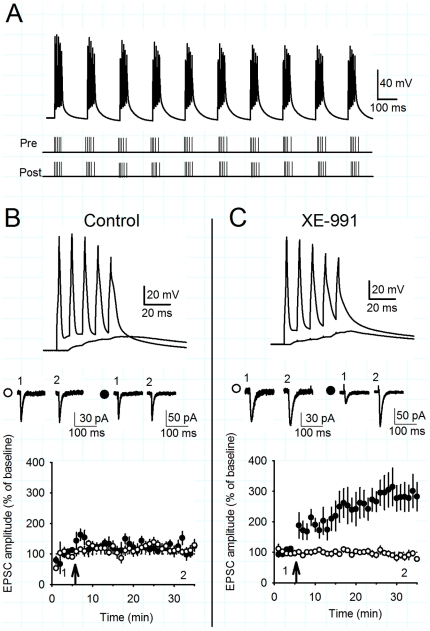
XE-991 facilitates the induction of LTP by theta burst pairing.A) Diagram of theta burst pairing (TBP) protocol. Top, voltage trace of TBP protocol recorded at the soma of a CA1 pyramidal cell. Middle and bottom traces illustrate the timing of inputs to the stimulating and recording electrodes evoking EPSPs and somatic action potentials respectively. B) TBP does not induce LTP under control conditions. Coincident TBP of subthreshold EPSPs and somatic action potentials induced no change in EPSC amplitude in the test (black circles) or control (white circles) pathways. The arrow indicates the timing of the TBP protocol. Example voltage traces show the initial burst of 5 coincident EPSPs and action potentials and a single test burst of 5 subthreshold EPSPs. Example current traces from a single experiment illustrating the mean EPSC response during the baseline (1) and at 30–35 minutes (2) in the test and control pathways. C) TBP does induce LTP in the presence of the Kv7 channel inhibitor XE-991. In the presence of XE-991 (10 µM), coincident TBP of subthreshold EPSPs and somatic action potentials induced pathway-specific LTP.